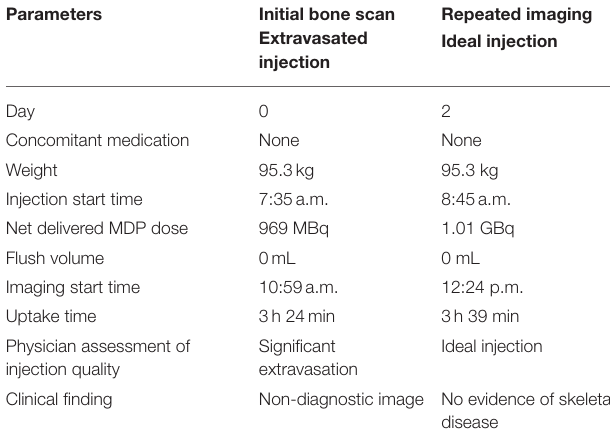
FIGURE 2 | Patient B MIP images. (A) Initial re-staging imaging. (B) Second re-staging extravasated injection. (C) Repeated imaging. Arrows indicate the areas of relevant uptake which were not visible after extravasation. TABLE 5 | Procedure parameters for Patient